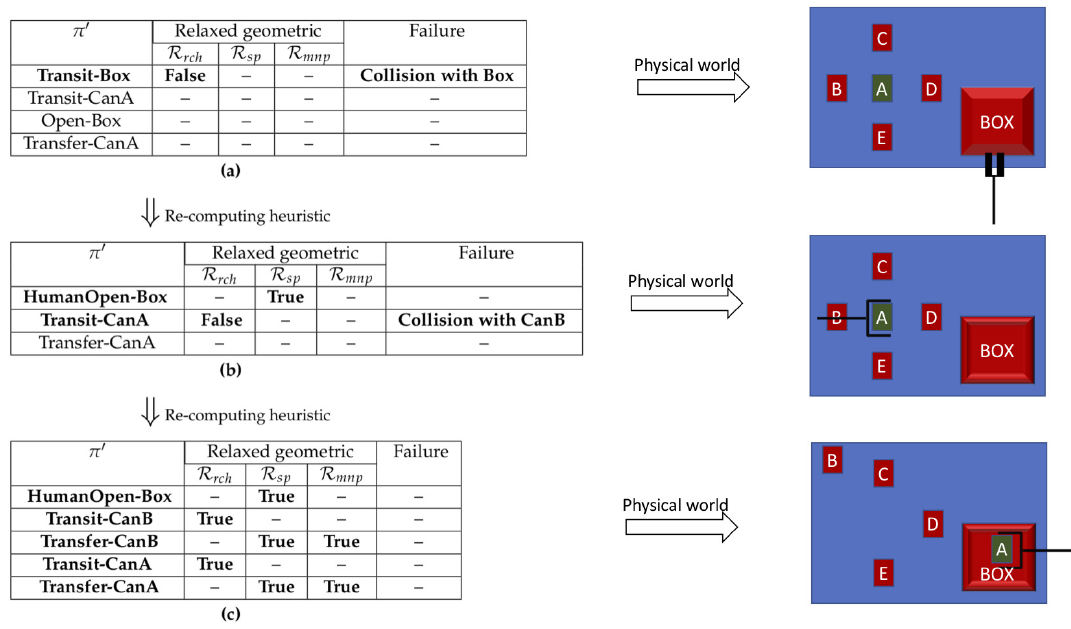
Figure 3. The steps of the computation of heuristic using the relaxed geometric reasoning and the corresponding physical world. The information highlighted in bold shows the relaxed planning actions which have been currently tested by the proposed relaxed geometric reasoning. Others are those which have not been tested yet. True and false values show whether the reasoner is successful or failed. ( a ) The transit action to reach the Box fails. ( b ) The transit action for the Can A fails due to collision with other objects. ( c ) The final geometrically feasible heuristic